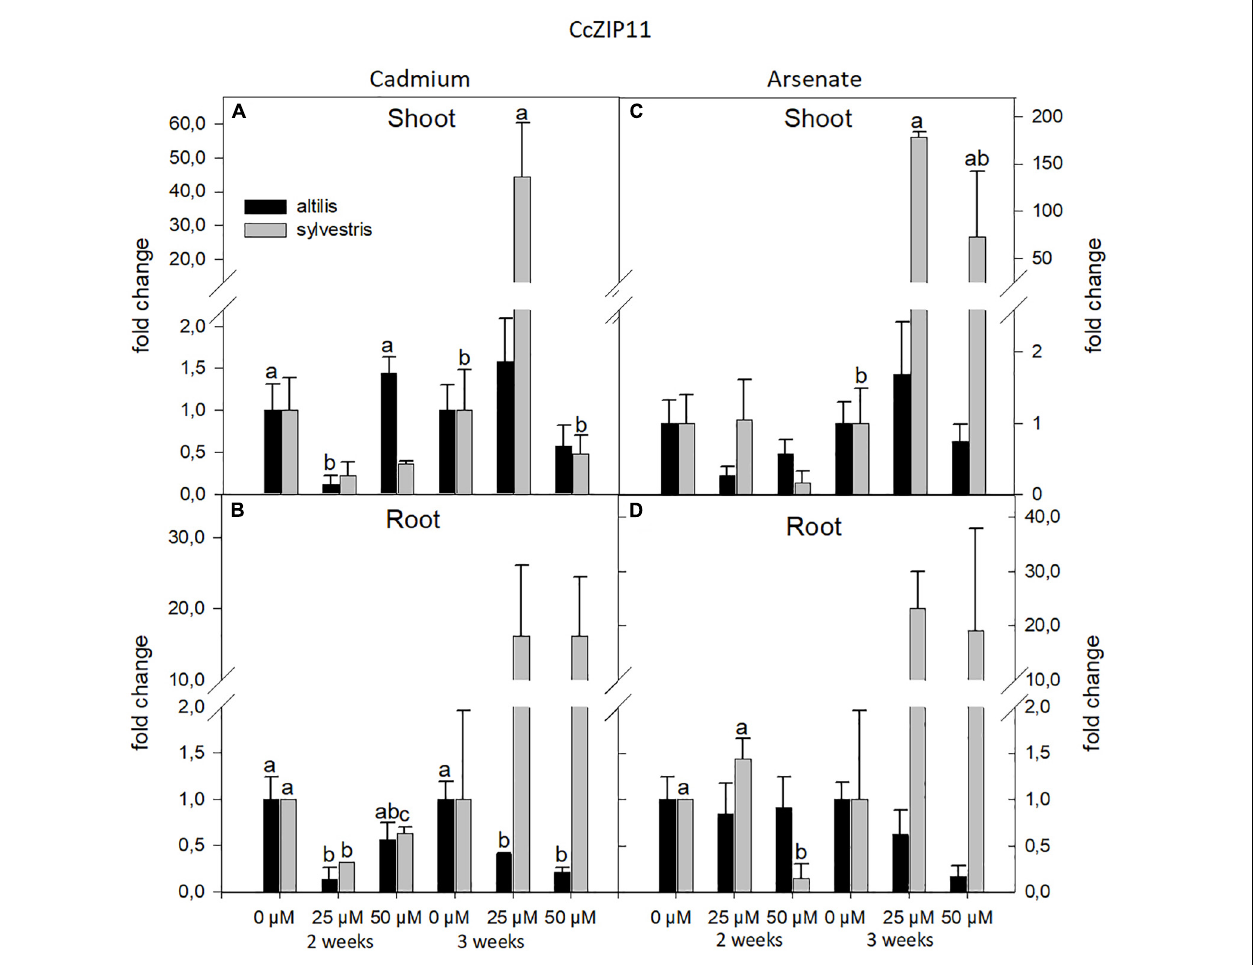
FIGURE 5 | The level of gene expression of ZIP11 in seedlings of altilis and sylvestris grown up to 2 and 3 weeks under Cd (A,B) and As (C,D) at different concentrations. The fold change is the Ct value with respect to the housekeeping genes (EF1 α and GAPDH) that is considered 1. The error bars represent the error mean of three biological replicates. Letters indicate only significantly different values ( P ≤ 0.05) between concentrations in each moment of sampling.